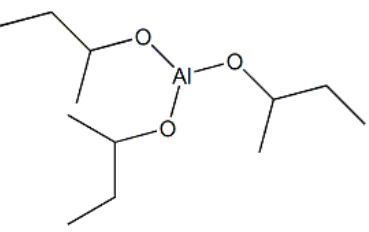
Figure 1. The structural formulas of aluminum tri-sec-butoxide.